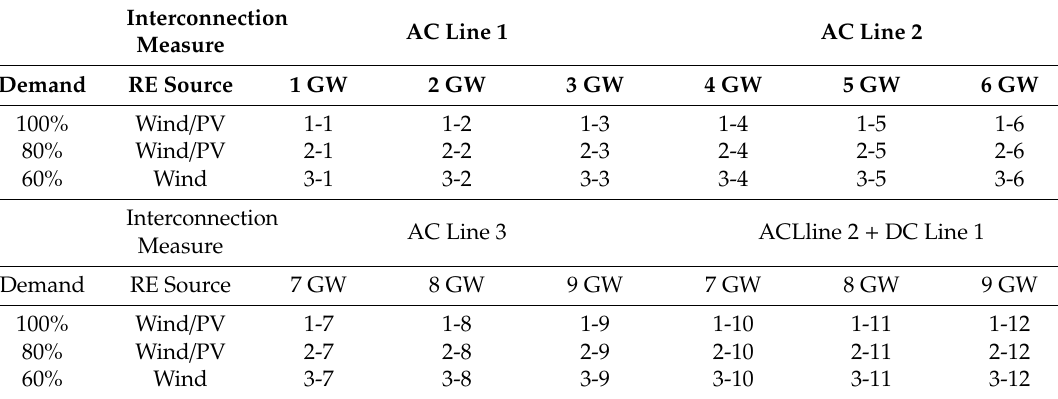
Table 4. Scenario for renewable energy interconnection based on various